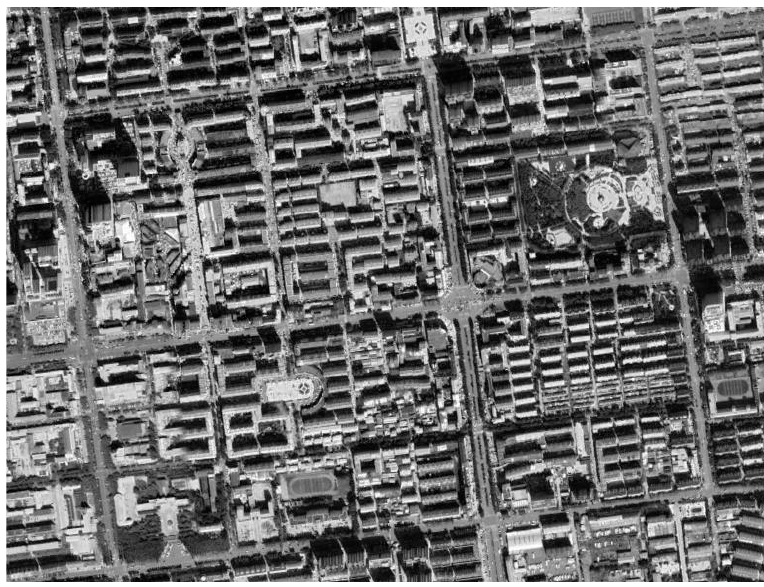
Figure 10. Schematic diagram of the selected area.